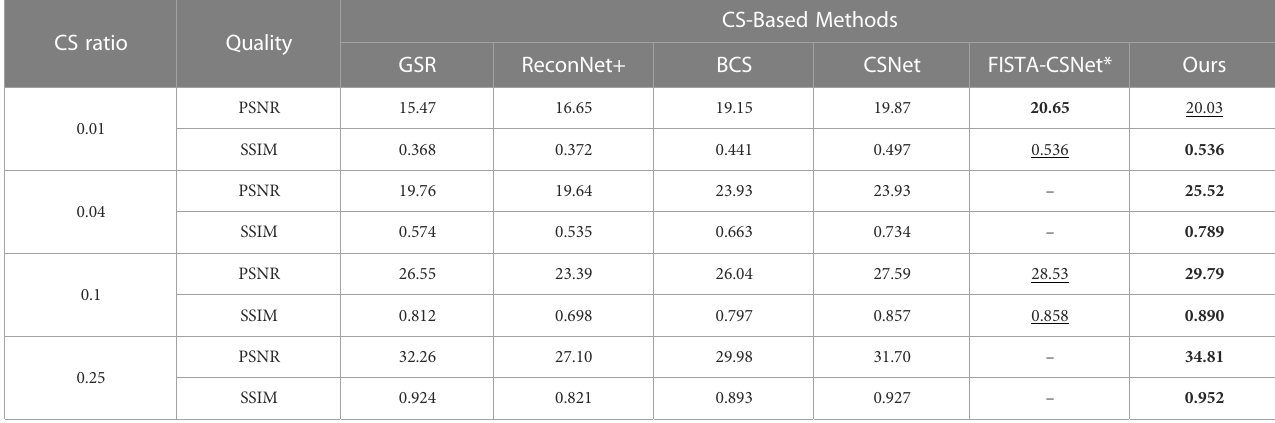
TABLE 1 Average PSNR and SSIM of different CS-based methods on Set11 and average running time (in sec) for reconstruction. CS-Based Methods CS ratio Quality GSR ReconNet+ BCS CSNet FISTA-CSNet*